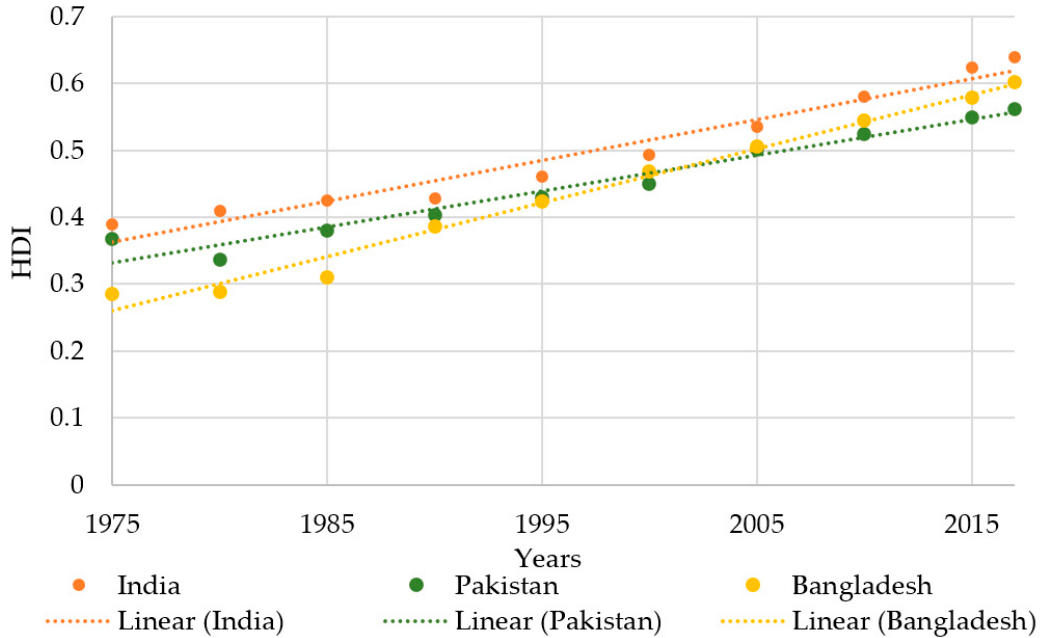
Figure 21. ECPC comparison of IPB shows Bangladesh and India making progress exponentially while the trend for Pakistan is